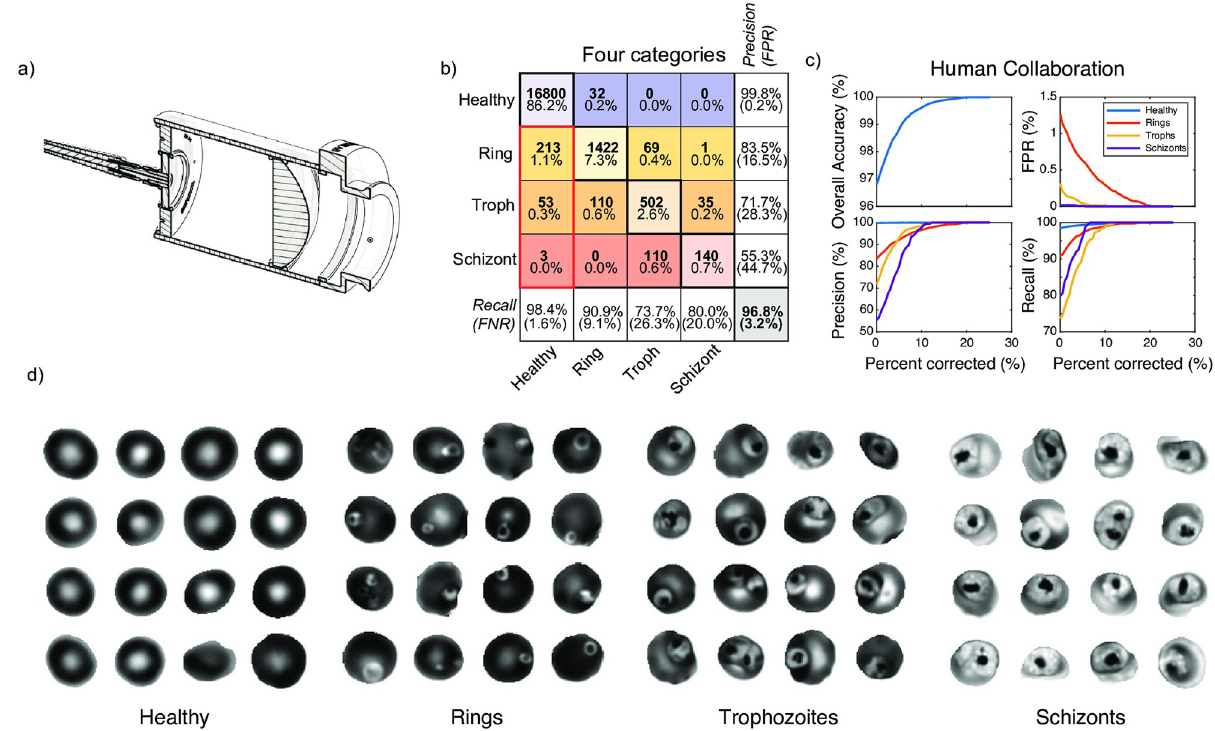
Fig 5. Commercial microscope with 405 nm excitation. Equipping a commercial widefield microscope with 405 nm excitation generates high- contrast label-free images of infected RBCs. a) Cross-sectional view of our fiber-coupled, collimated light source used for near-UV excitation through the microscope transillumination port. b) Confusion matrix from the single-wavelength validation dataset of the classifier trained with 405 nm images from the commercial microscope. c) Results from human collaboration, ie. human correction of labels for only the cells with the lowest classifier confidence. All four graphs depict performance metrics as a function of the total percentage of cells corrected. Upper left: Overall accuracy, Upper right: False-Positive Rate, Lower left: Precision, and Lower right: recall. The human plus machine classifier achieves perfect performance after correction of 20% of the dataset. d) Example cell images of all four categories, acquired at 405 nm. From left to right: Healthy, Rings, Trophozoites, and Schizonts.